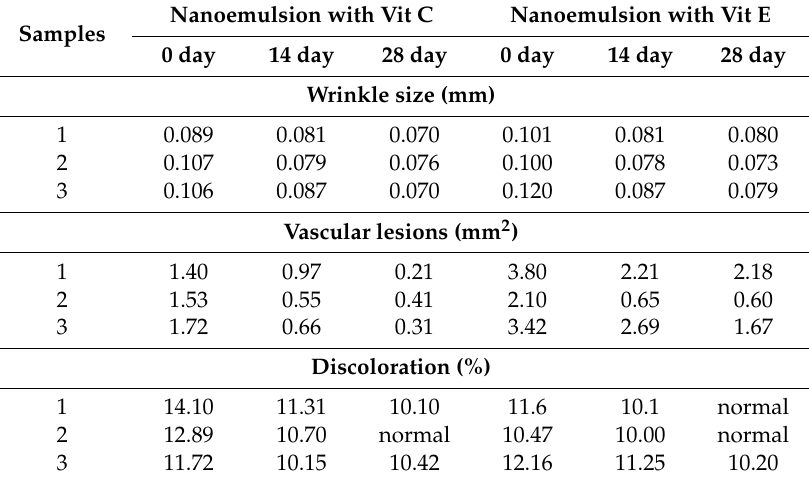
Figure 6. Images of correct skin structure before application. Table 2. Wrinkle size, vascular lesions and discoloration after application of nanoemulsion with Vit C and Vit E, respectively.